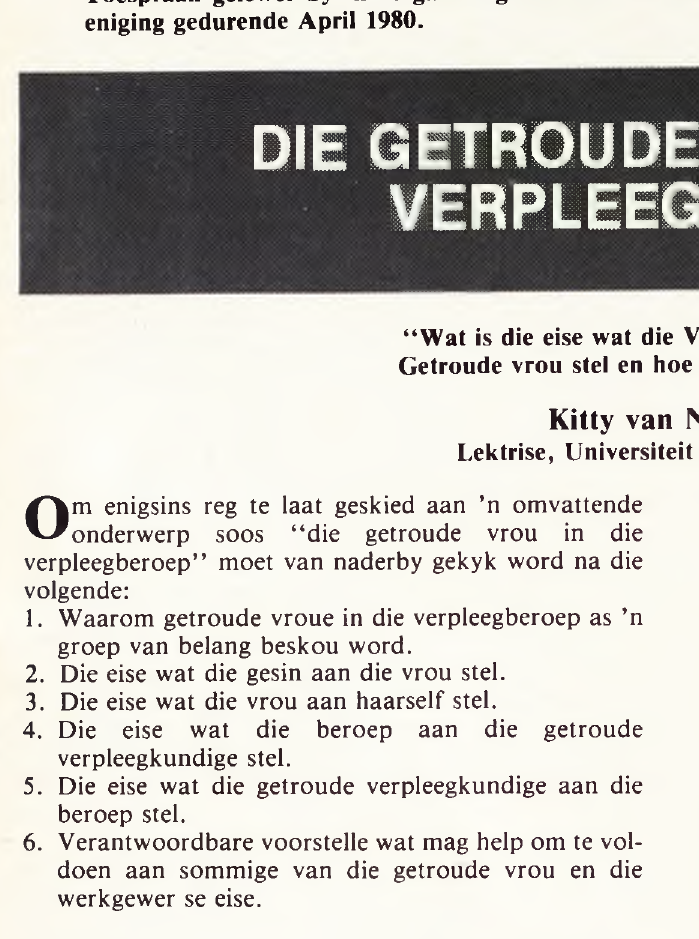
eniging gedurende April